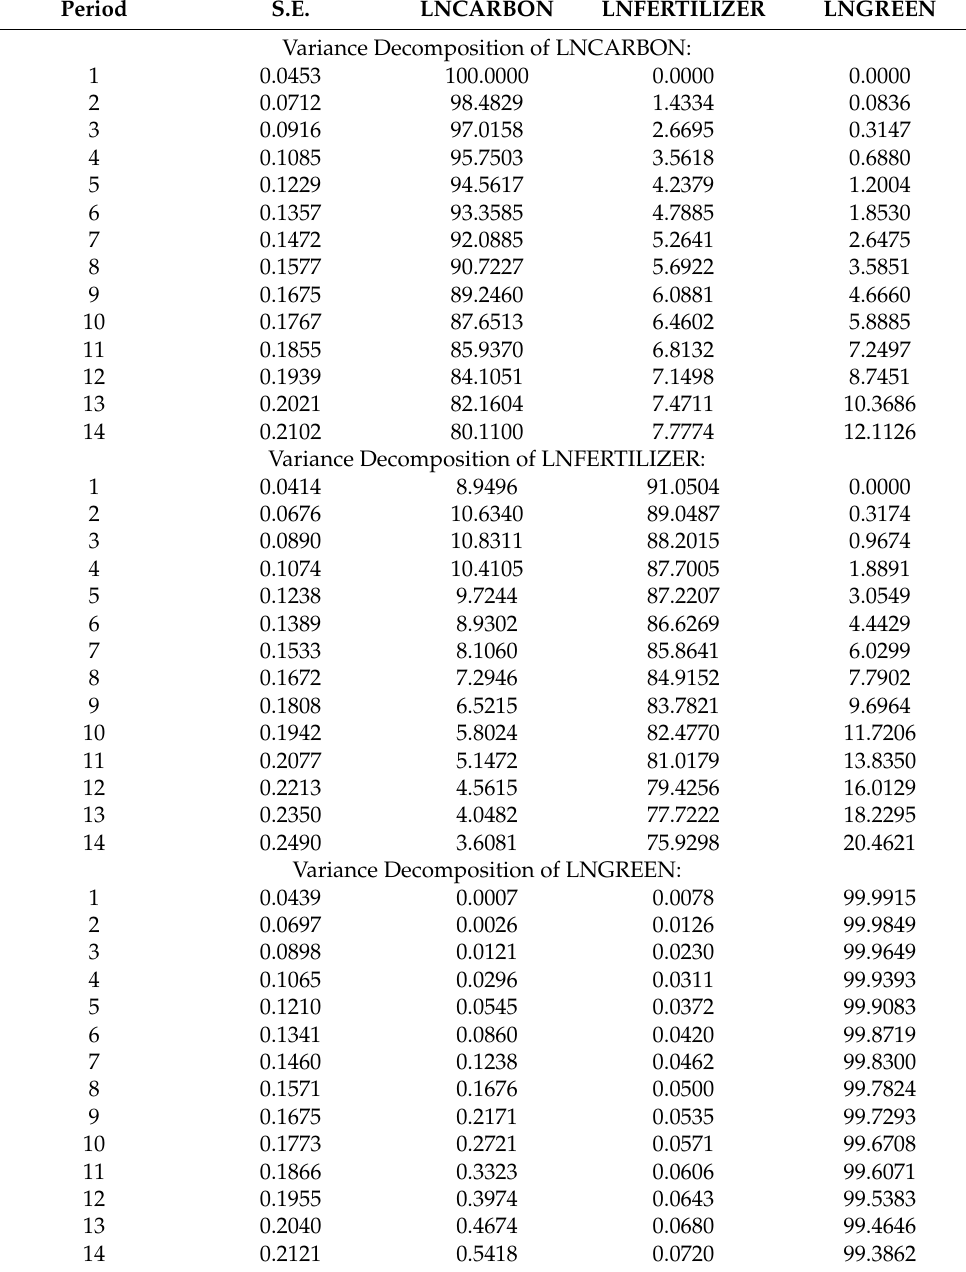
Table 10. The impulse response and variance decomposition